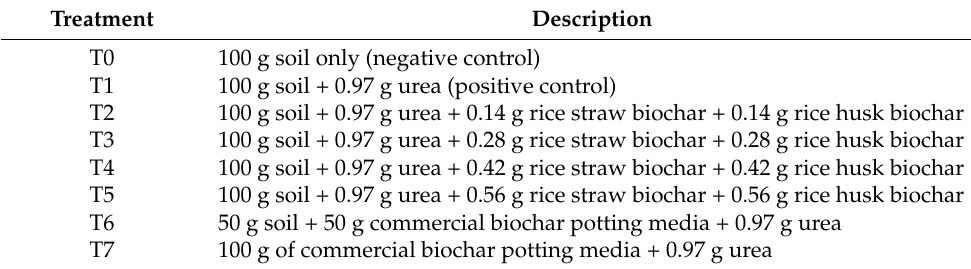
Table 1. Treatments evaluated in ammonia volatilization study.